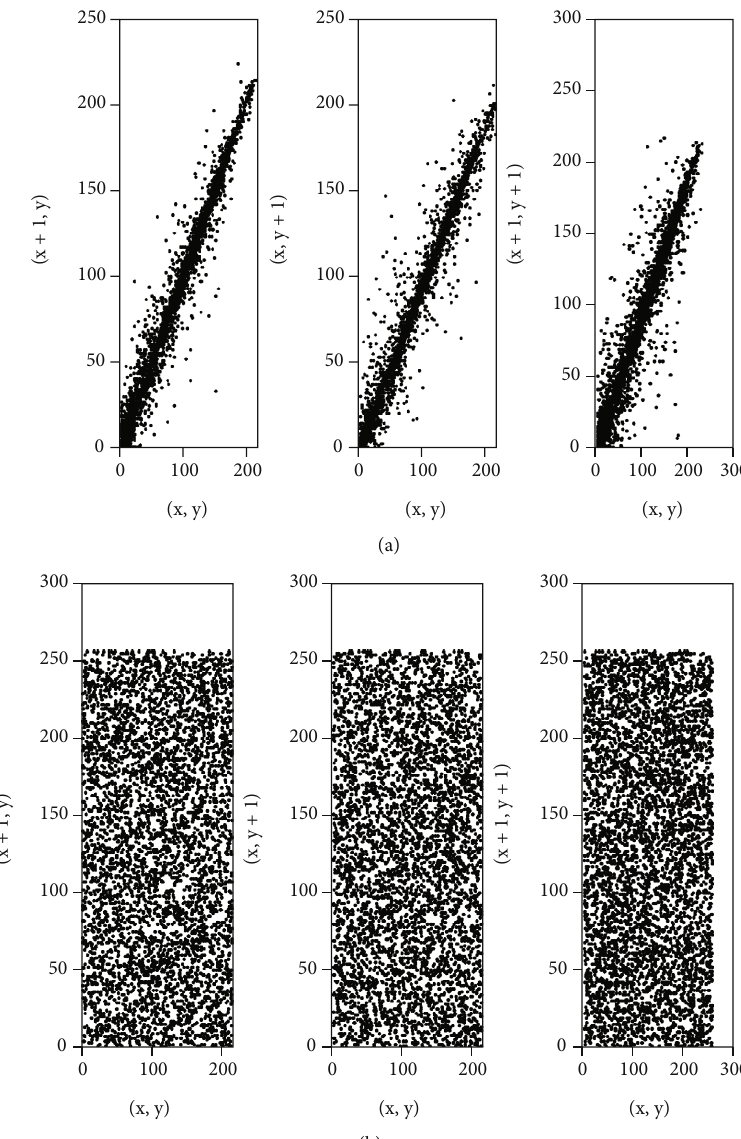
Figure 9: Correlation analysis of girl. (a) Correlation analysis of plaintext. (b) Correlation analysis of